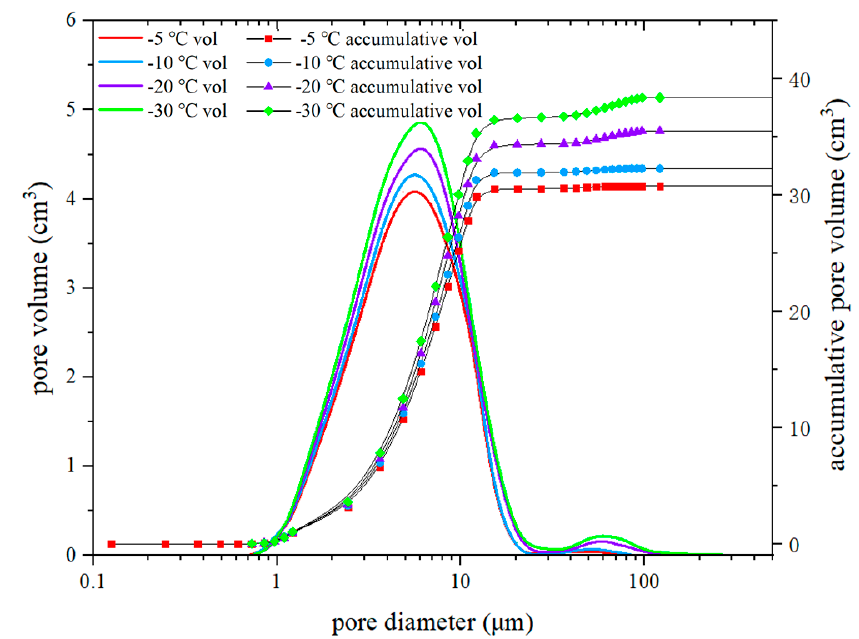
Figure 6. The pore volume distributions of thawed soils under different freezing temperatures.